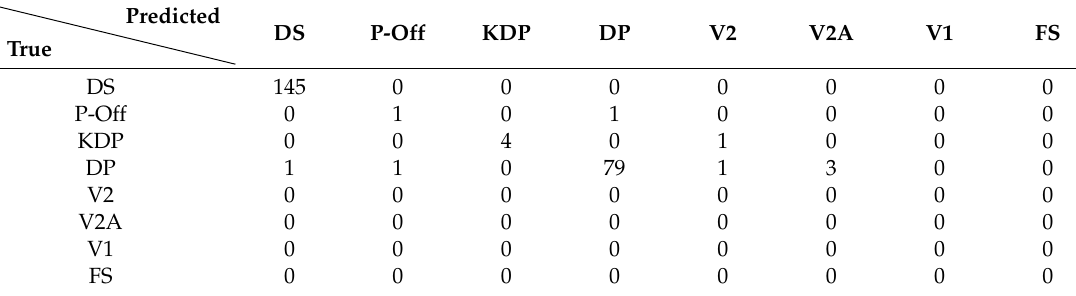
Table 11. Confusion matrix for the natural course, classical style validation set of skier 3 when using the sports biomechanics configuration of